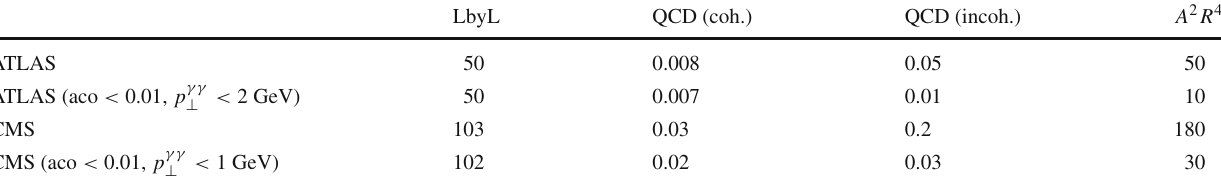
on the combined transverse momentum p (ATLAS) case are shown. The cross sections for the light-by-light scat- tering (LbyL) and QCD-initiated photon pair production, in both the coherent and incoherent cases, are given. The result of simply scaling the pp cross section (including the pp survival factor) by A 2 R 4 with R = 0 . 7 is also shown